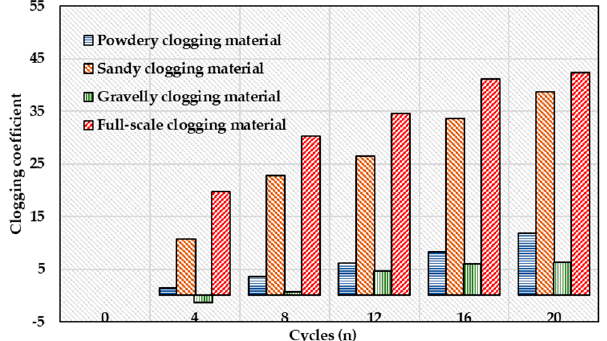
ffi cient COF-OGFC with di ff erent clogging Figure 16. Clogging coefficient COF-OGFC with different clogging materials. Figure 16. Clogging coe